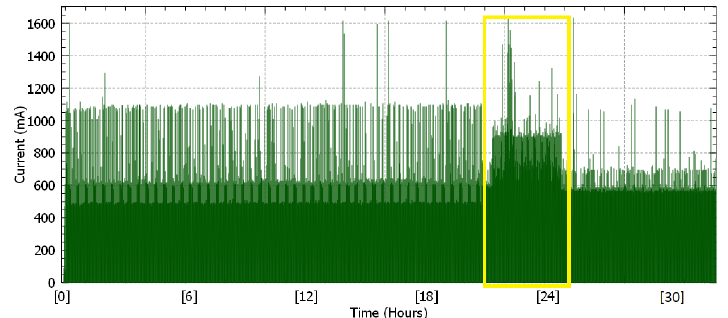
Figure 5. Measurements without using a software filter.